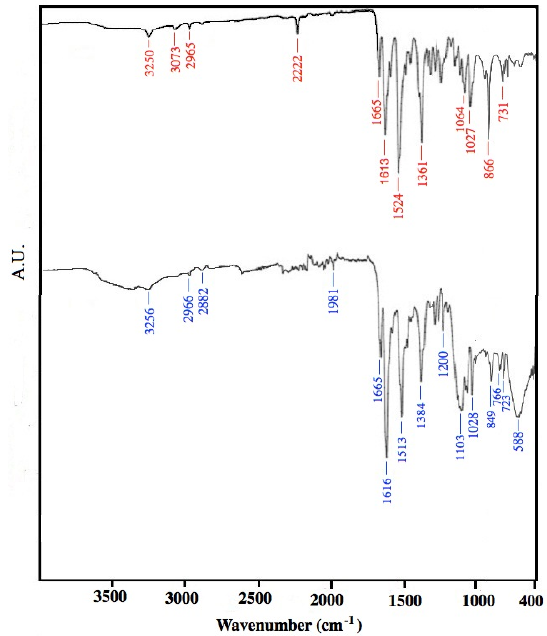
Figure 8. FT-IR spectra of ( a ) Ni-phthalocyanine; and ( b ) Cu-phthalocyanine obtained in parallel-plate reactor at 50